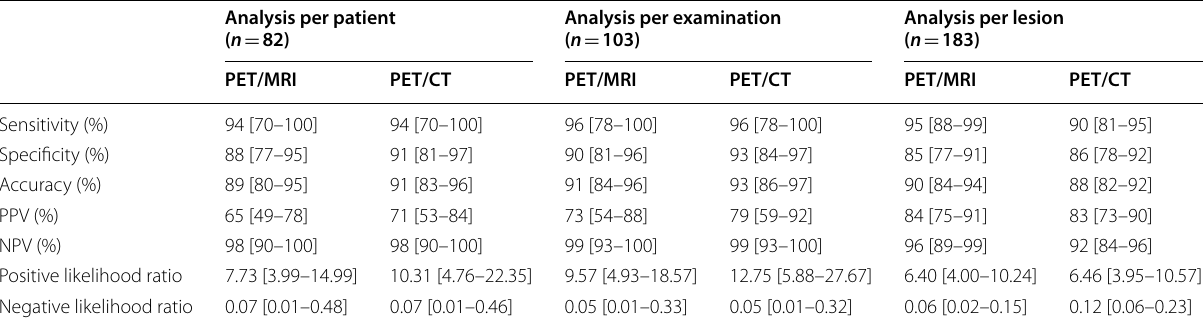
Table 3 Diagnostic performance of PET/MRI and PET/CT for a score were calculated using the Clopper–Pearson method